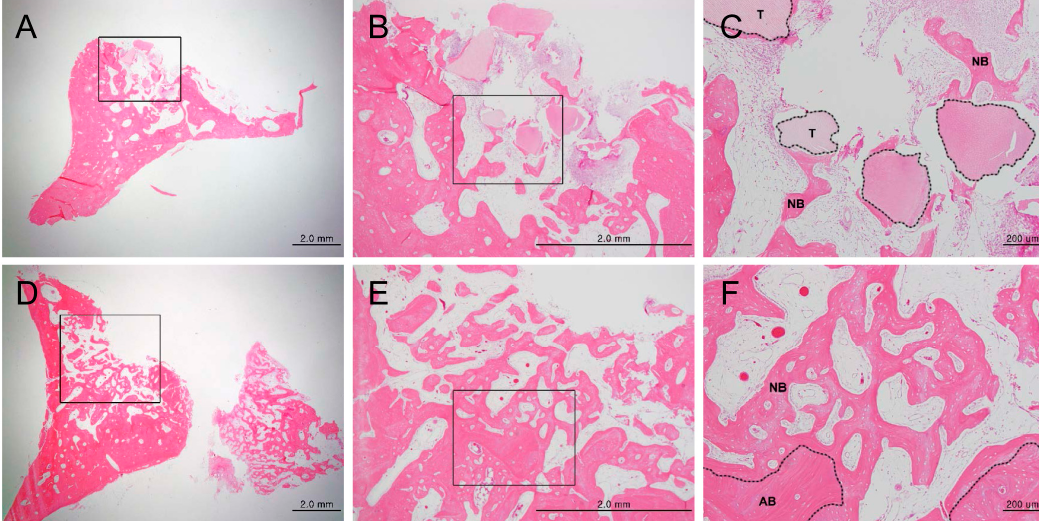
Figure 3. Histological analysis of new bone formation at the bone defect area after four weeks, by hematoxylin/eosin staining (magnification: ( A , D ) 12.5×; ( B , E ) 40×; ( C , F ) 100×). ( A – C ) Experimental group (DDM fixed with rhBMP-2); ( D – F ) Control group (autogenous bone graft). Figures ( B ) and ( E ) are higher magnification views of figures ( A ) and ( D ), respectively. Figures ( C ) and ( F ) are higher magnification views of figures ( B ) and ( E ), respectively. ( C ): The area enclosed within the dotted line represents DDM fixed with rhBMP-2, and newly-formed bone seen around the DDM. ( F ) The area within the dotted line indicates autogenous bone graft, and newly-formed bone found around the autogenous bone graft. Scale bars: 2.0 mm ( A , B , D , E ), 200 μ m ( C , F ). T: DDM fixed with rhBMP-2, NB: new bone, AB: autogenous bone.